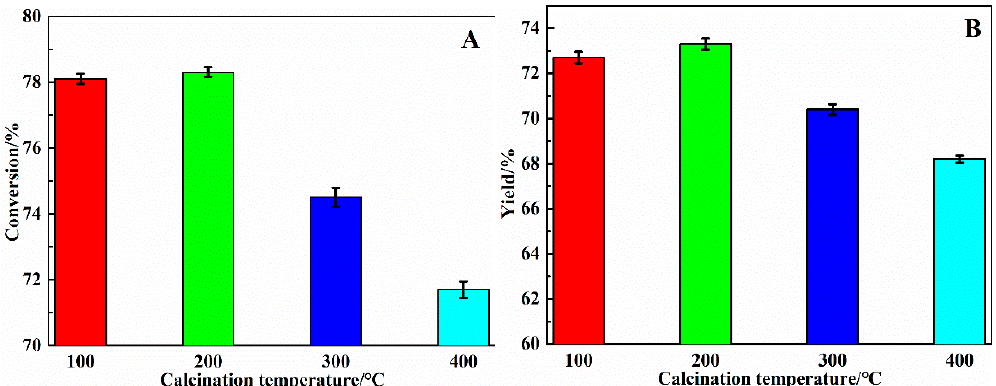
Figure 10. Effect of calcination temperatures on ( A ) the n-hexane conversion, and ( B ) the yield of iso-alkanes (i-C 5 and i-C 6 ).